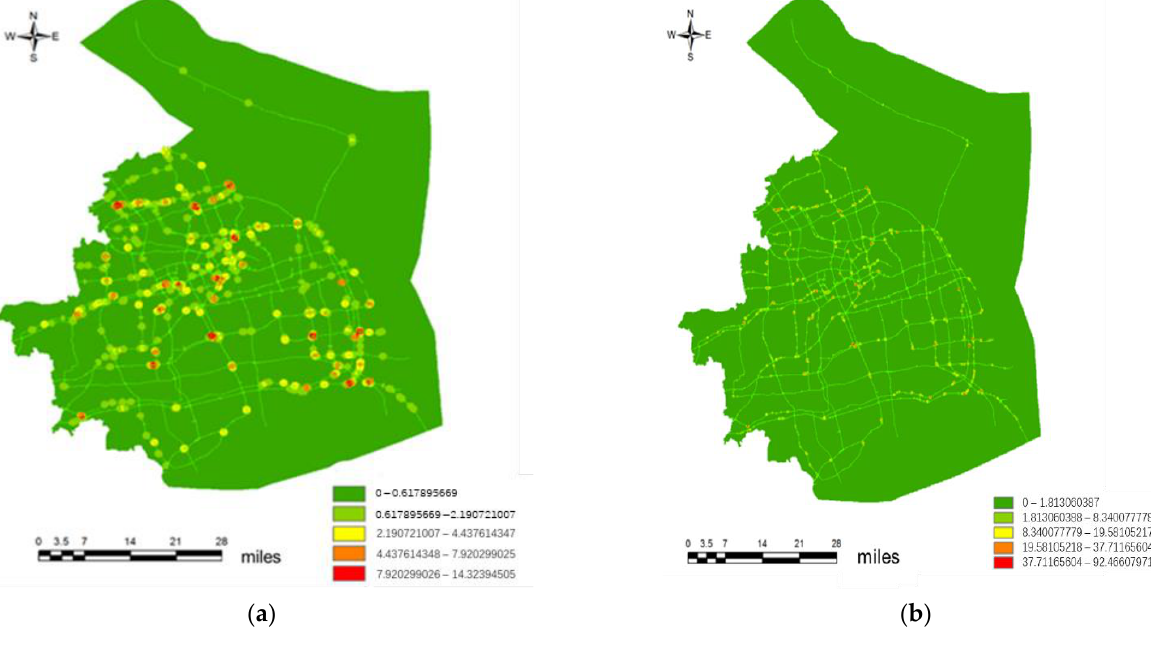
Figure 5. Identification results of traffic accident black spots by adaptive kernel density estimation method. ( a ) Recognition result graph. ( b ) Black spot road network distribution.